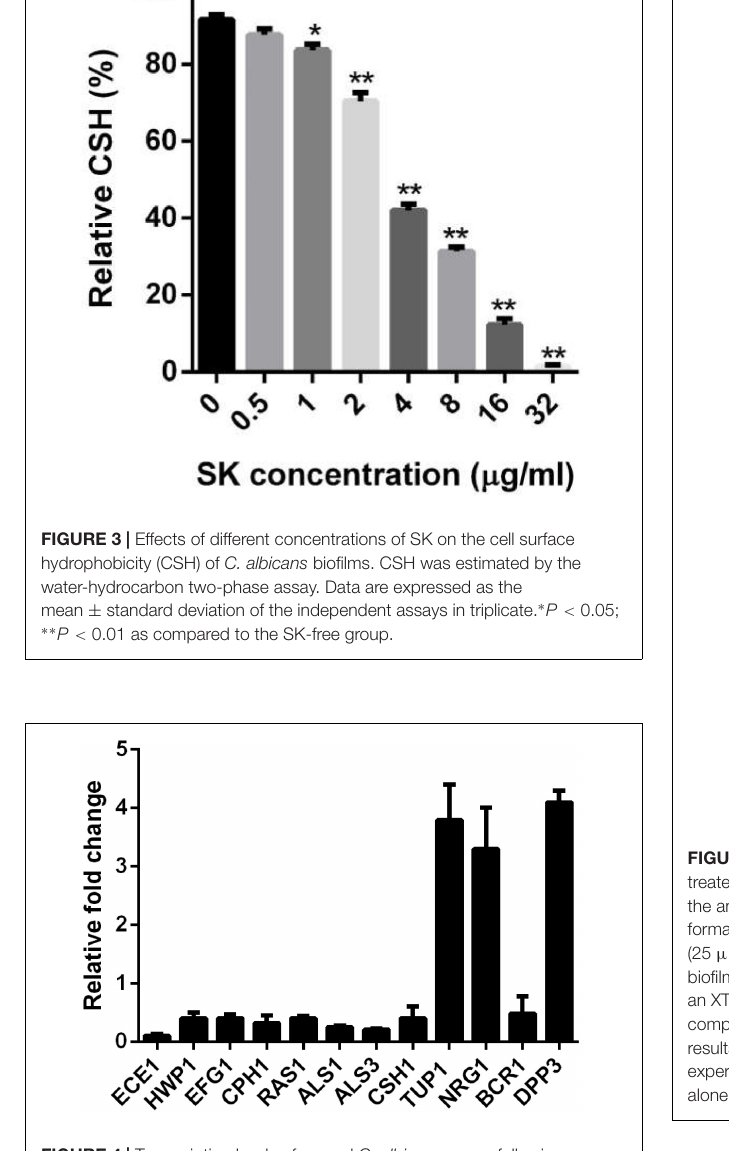
FIGURE 4 | Transcription levels of several C. albicans genes following treatment with 2 µ g/ml of SK were detected by real-time reverse transcription PCR (RT-PCR). The mRNA levels were normalized on the basis of their 18S rRNA levels. Gene expression was indicated as the fold increase in SK-treated biofilm cells relative to that of the untreated biofilm cells. Data are expressed as the mean ± standard deviation of the independent assays in triplicate.